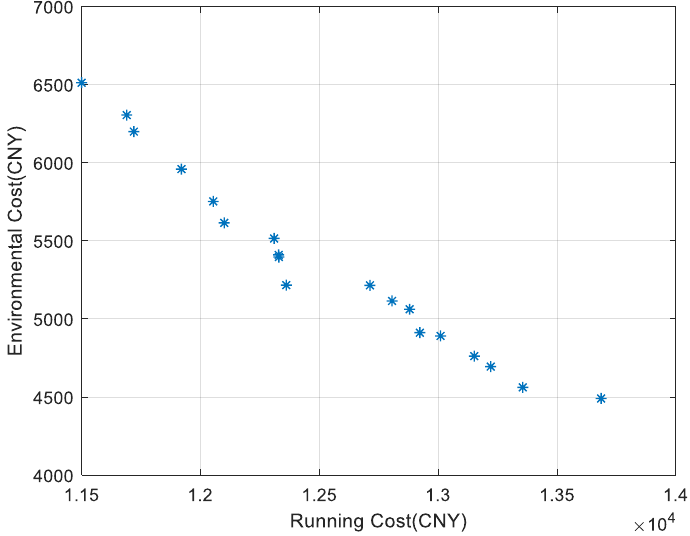
Figure 9. The Pareto solution set provided by the multi-objective RSSA for a typical day in summer.